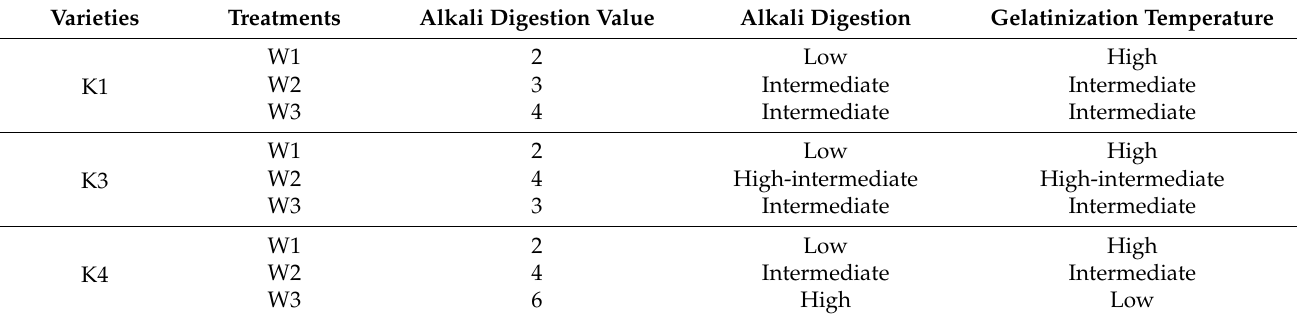
Table 3. Gelatinization temperature of rice seeds based on 7-scale point of alkali digestion under irrigation intervals.